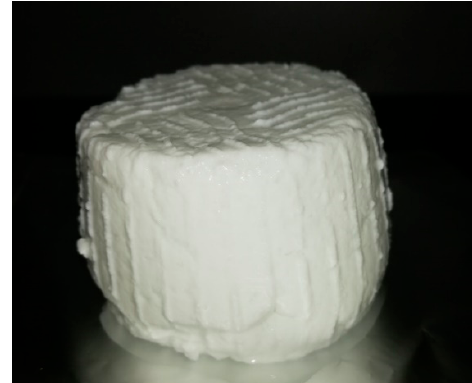
Figure 1. Fresh cheese from donkey milk obtained by coagulation with microbial rennet from Mucor miehi . Table 3. Technological conditions for manufacturing cheese from donkey milk.